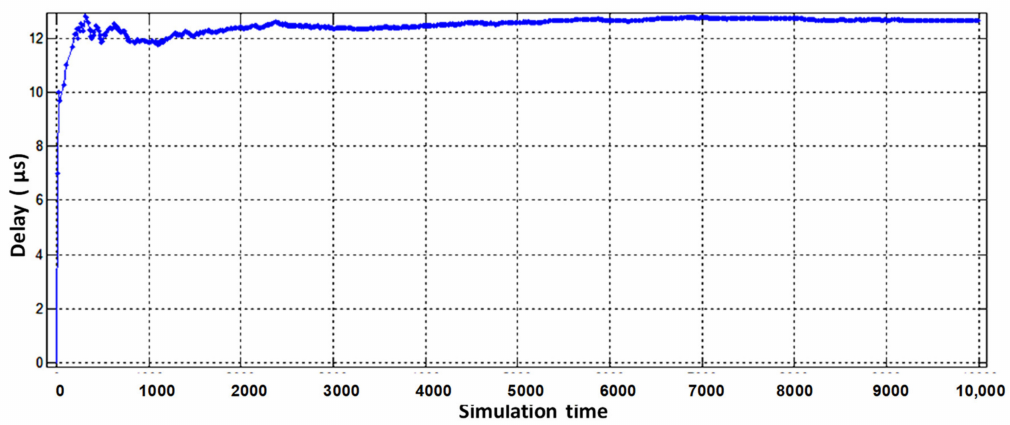
Figure 14. The sum of processor and interface packet latency of the physical router when serving aggregate flow.